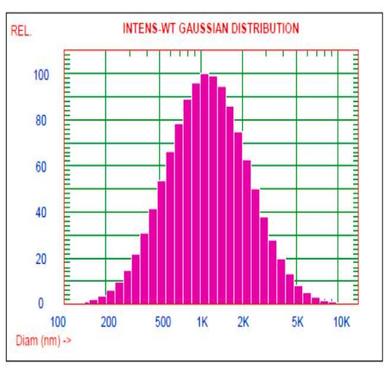
Cumulative particle size distribution of milled SiO2@C powders prepared from rice husk.